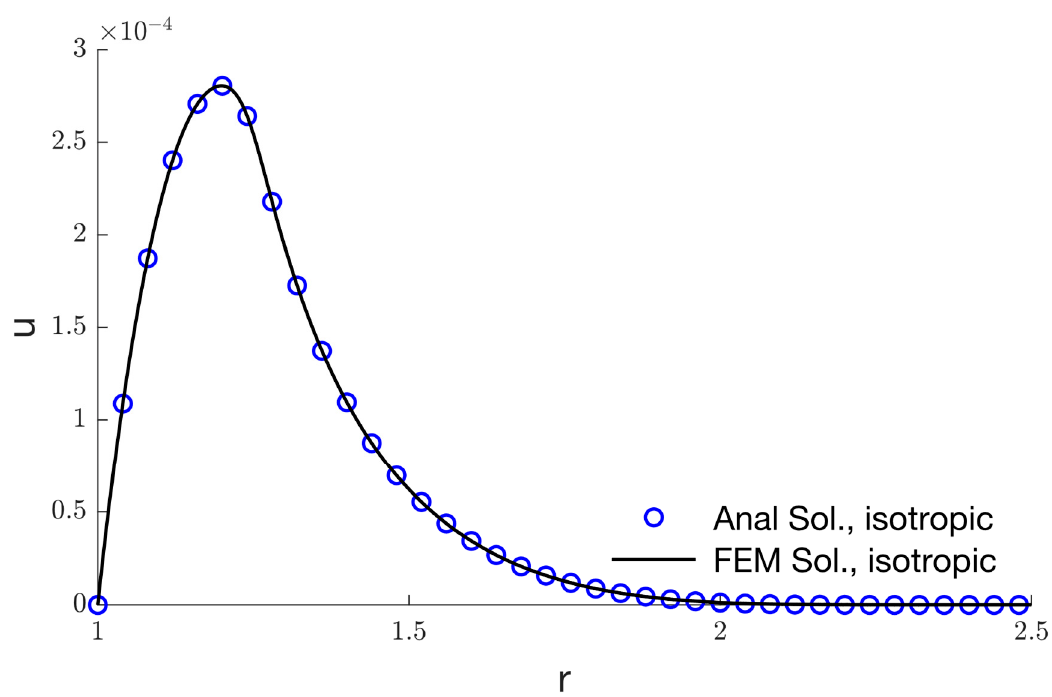
Figure 15. The radial displacement variation 𝑢 for isotropic material.